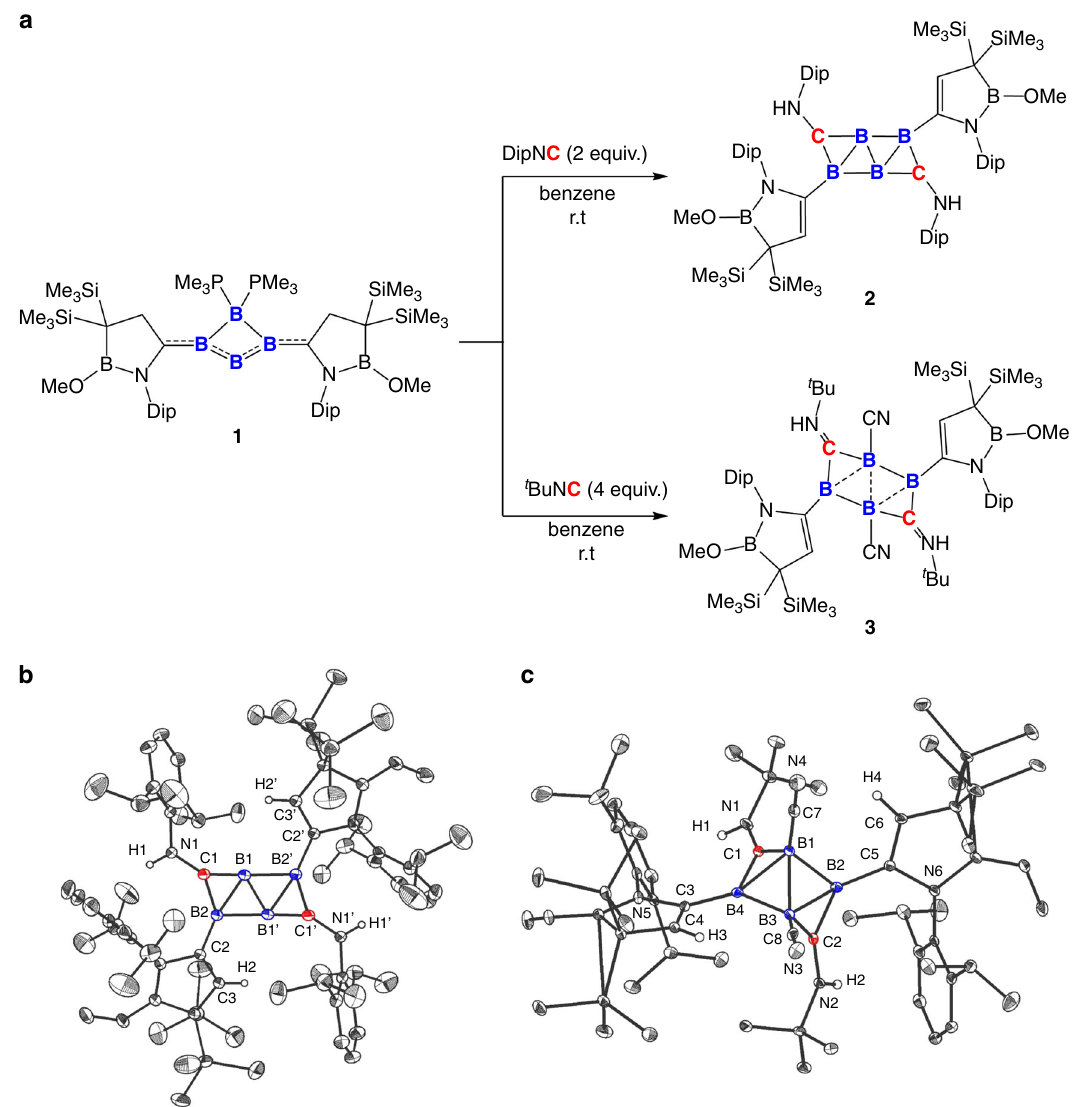
Fig. 2 Synthesis and characterization of 2 and 3. a Synthesis of 2 and 3 from tetraatomic boron(0) 1 with isonitriles (Dip = 2,6-diisopropylphenyl, t Bu = tertiary butyl). b Solid-state structure of 2 ; hydrogen atoms except for those on N1, N1 ’ , C3, C3 ’ are omitted for clarity. c Solid-state structure of 3 ; hydrogen atoms except for those on N1, N2, C4, C6 are omitted for